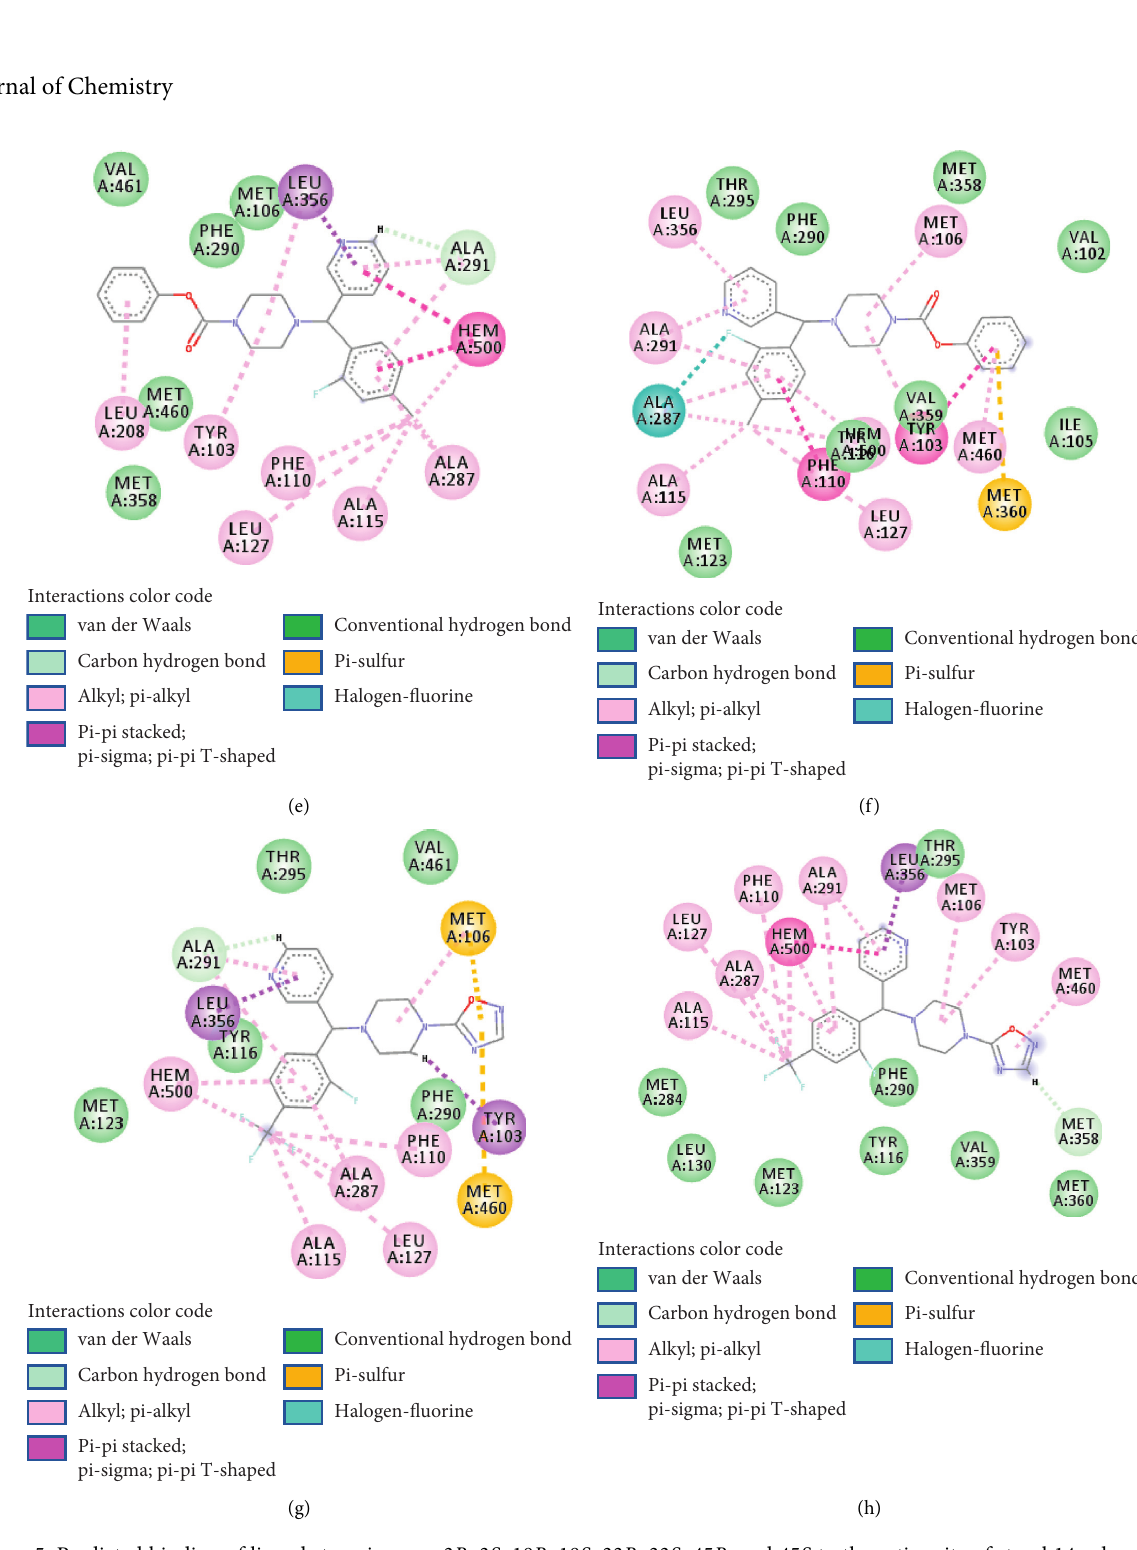
Figure 5: Predicted binding of ligand stereoisomers 3 R , 3 S , 18 R , 18 S , 33 R , 33 S , 45 R , and 45 S to the active site of sterol 14 α -demethylase (CYP51) from Trypanosoma cruzi . (a) Molecule 3( R ). (b) Molecule 3( S ). (c) Molecule 18( R ). (d) Molecule 18( S ). (e) Molecule 33( R ). (f) Molecule 33(S). (g) Molecule 45( R ). (h) Molecule 45( S